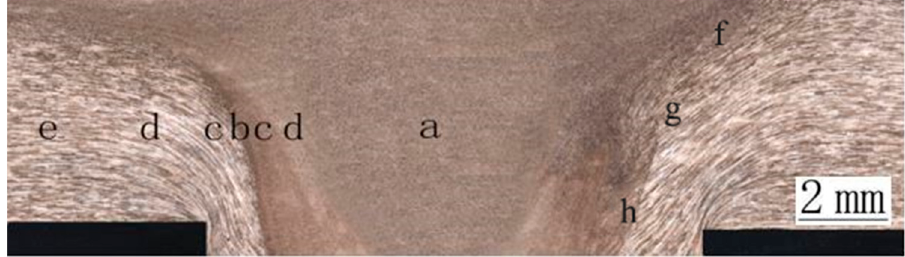
Figure 5. Macrograph of FPW joint welded by optimal condition.